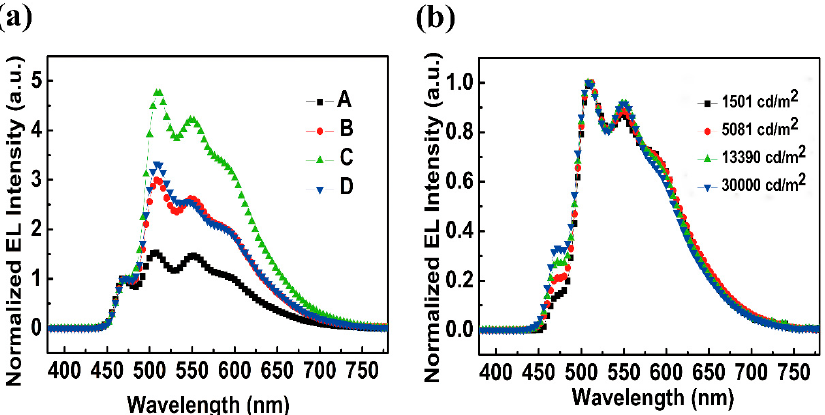
Figure 5. The normalized EL spectra of devices A–D at 7 V ( a ) and the normalized EL spectra of device C at different luminance ( b ).